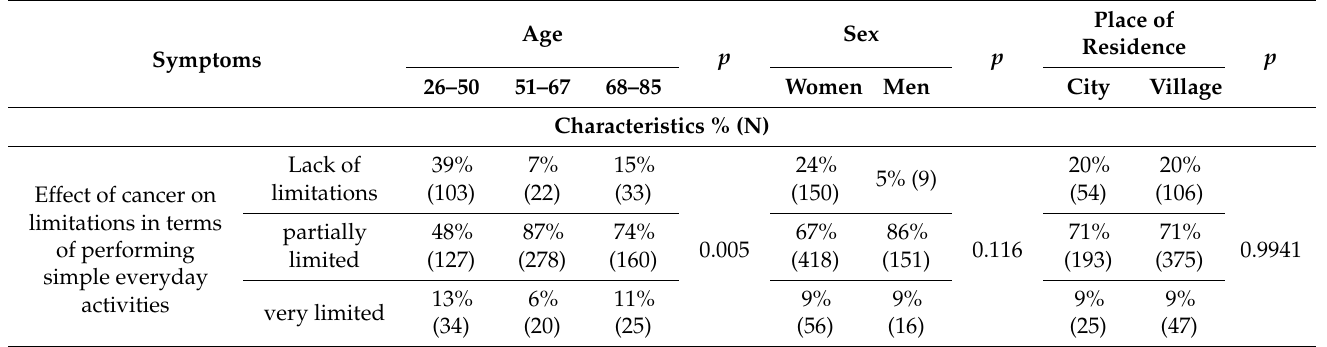
Table 4. Impact of cancer-related symptoms on limitations in performing simple everyday activities.